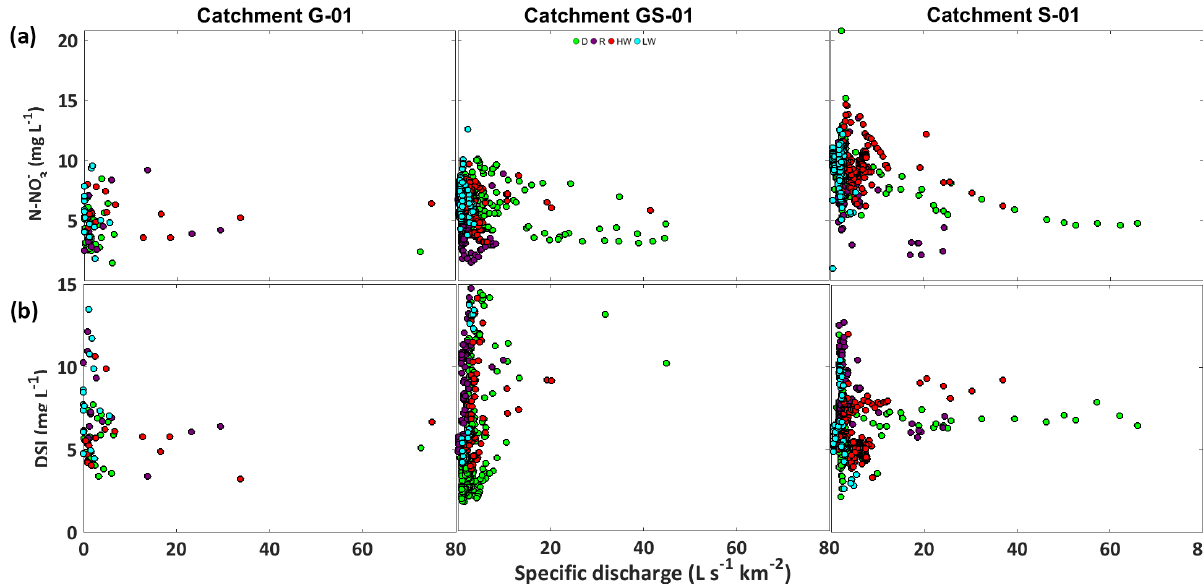
Figure 3. Relationship between specific discharge and (a) nitrate, on the other hand, and (b) dissolved silica, on the other hand, for three headwater catchments (G-01, GS-01, and S-01) in Brittany France. Chemistry data from daily automatic sampling supplemented by sub-daily sampling for catchments GS-01 and S-01 during discharge events (see “Methods” section for detailed sampling description). Data points are colored by hydrologic period (see Fig. 2 for